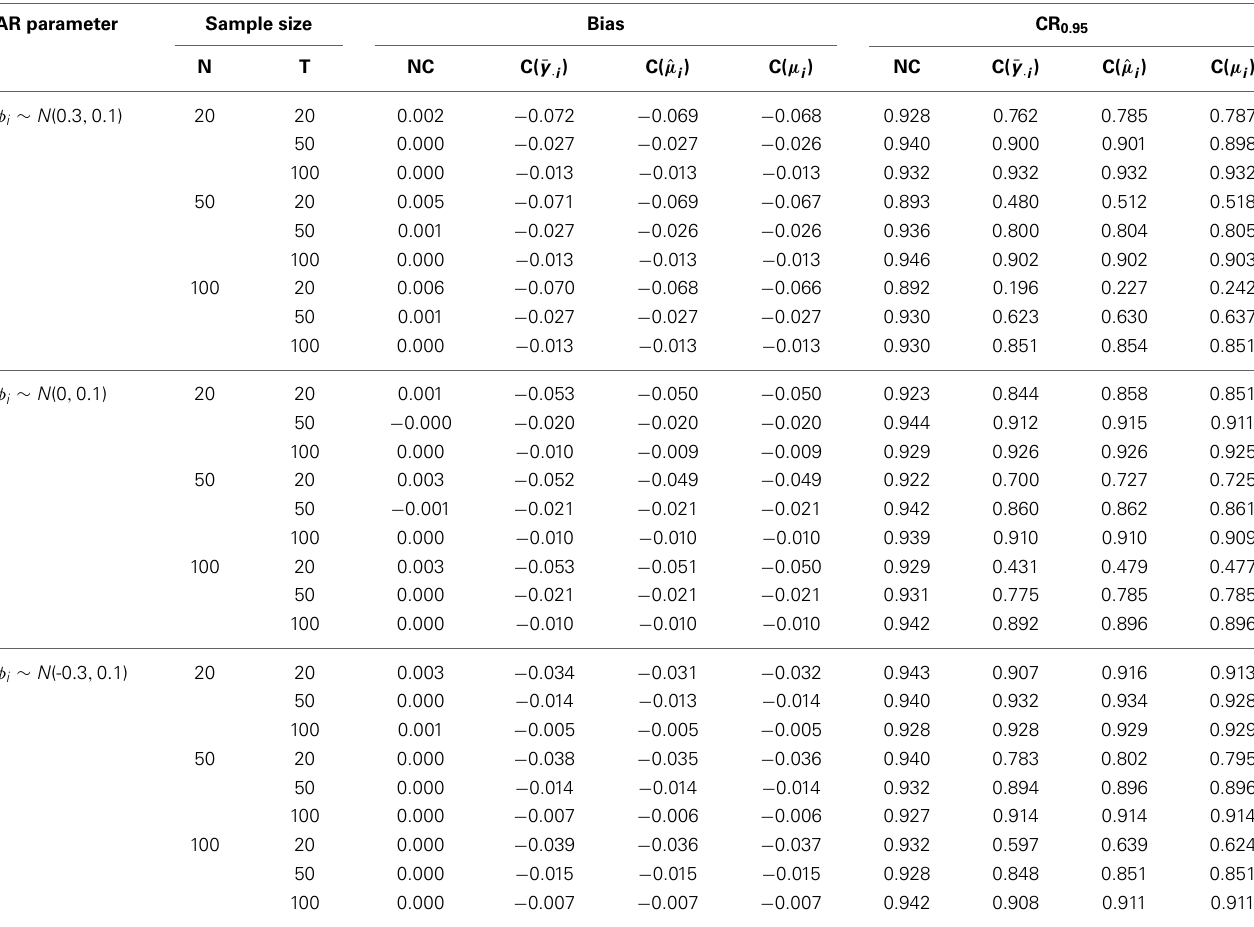
Table 4 | Bias and coverage rates for fixed autoregressive parameter φ in multilevel autoregressive model under diverse scenarios. AR parameter Sample size